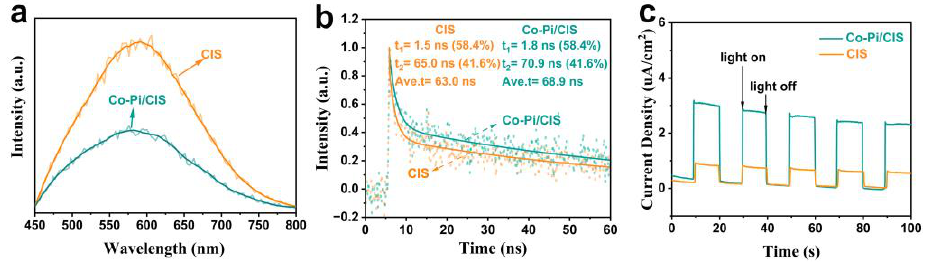
Figure 6. ( a ) Steady-state photoluminescence (PL) spectra, ( b ) time-resolved PL (TRPL) decay, ( c ) transient photocurrent-time (I-t) plots of CIS and Co-Pi/CIS.